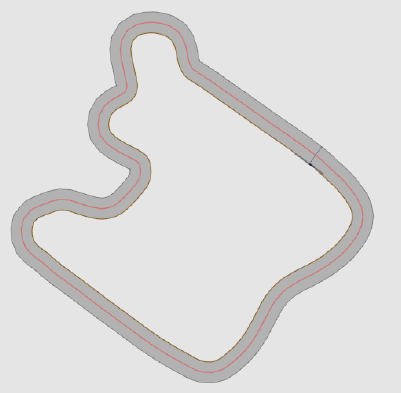
Figure 24. Third round driving test circuit.